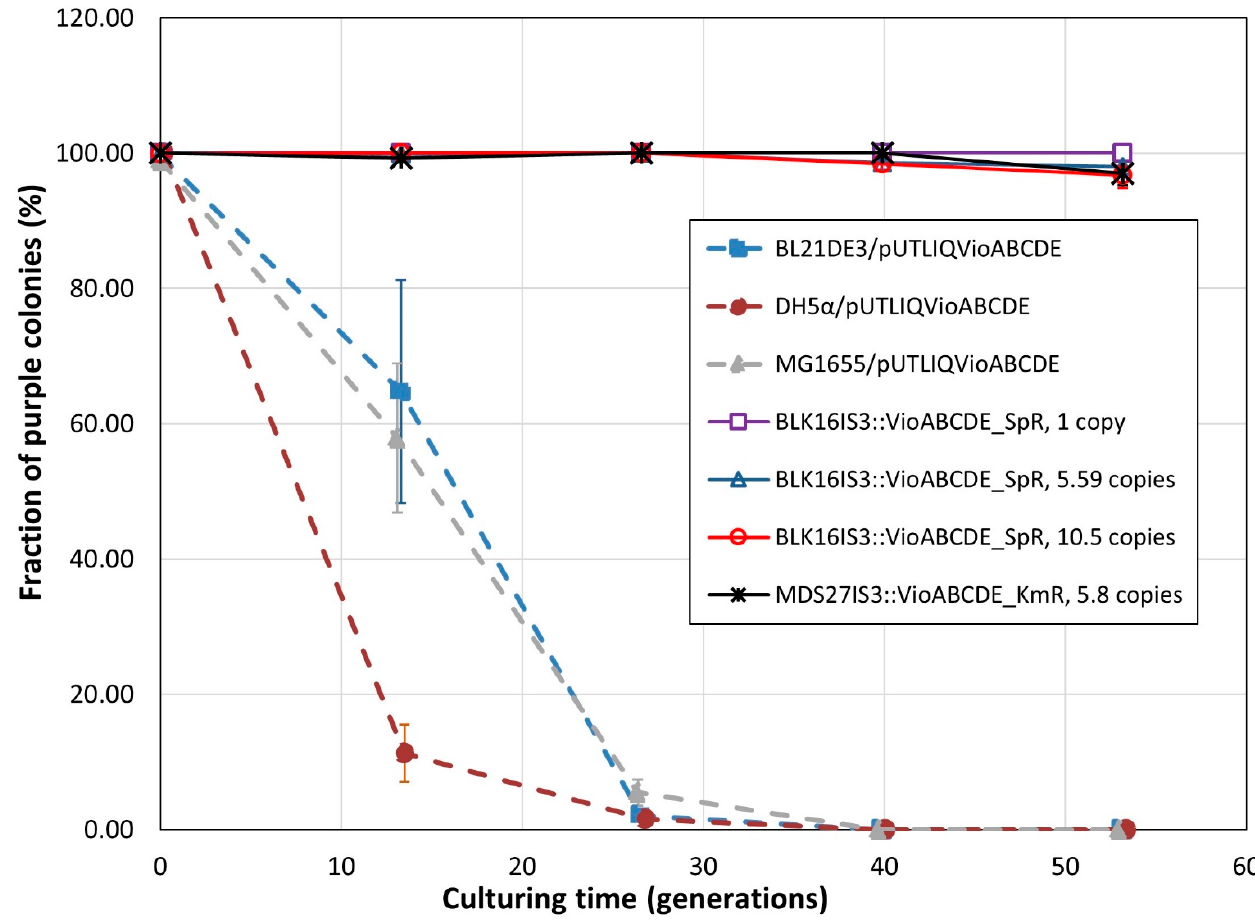
Figure 8. Fractions of violacein-producing cells within bacterial cultures grown in the lack of antibiotic selection. Dashed lines mark strains carrying plasmid pUTLIQvio_ABCDE, solid lines mark strains carrying an IS 3 :: vioABCDE cassette on their chromosomes, as indicated in the legend. All values are means of three biological replicates. Error bars mark the standard error of the means.